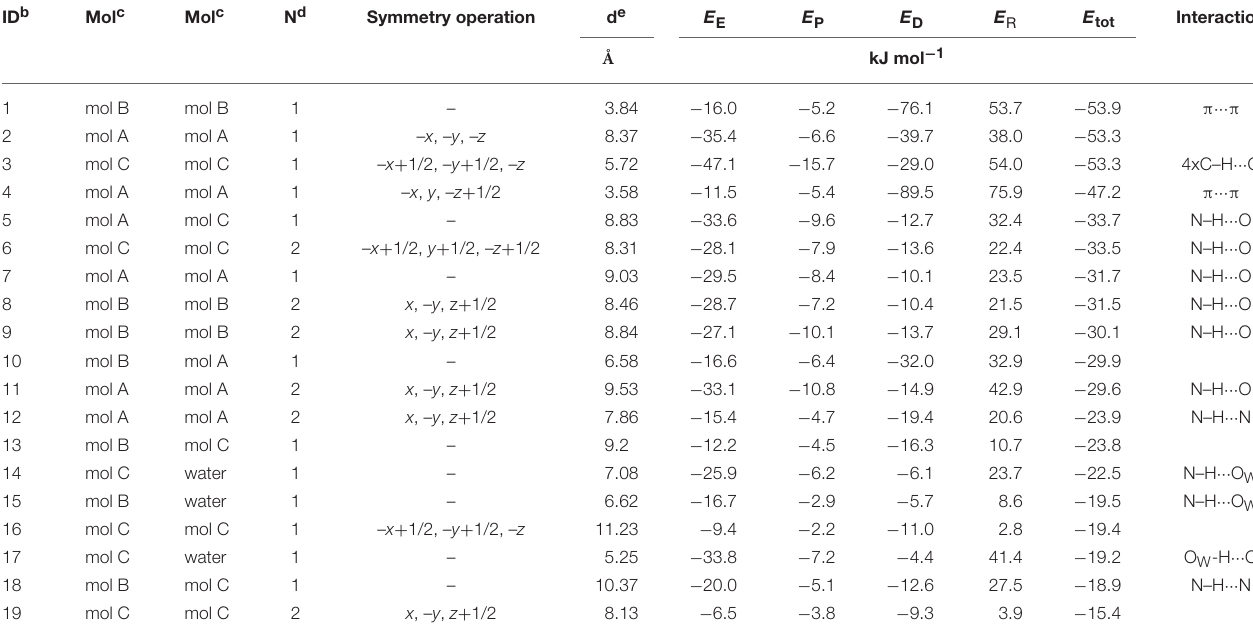
TABLE 2 | Pair-wise intermolecular interaction energies a ( Figure 3C ) of DDS 0.33-Hy . ID b Mol